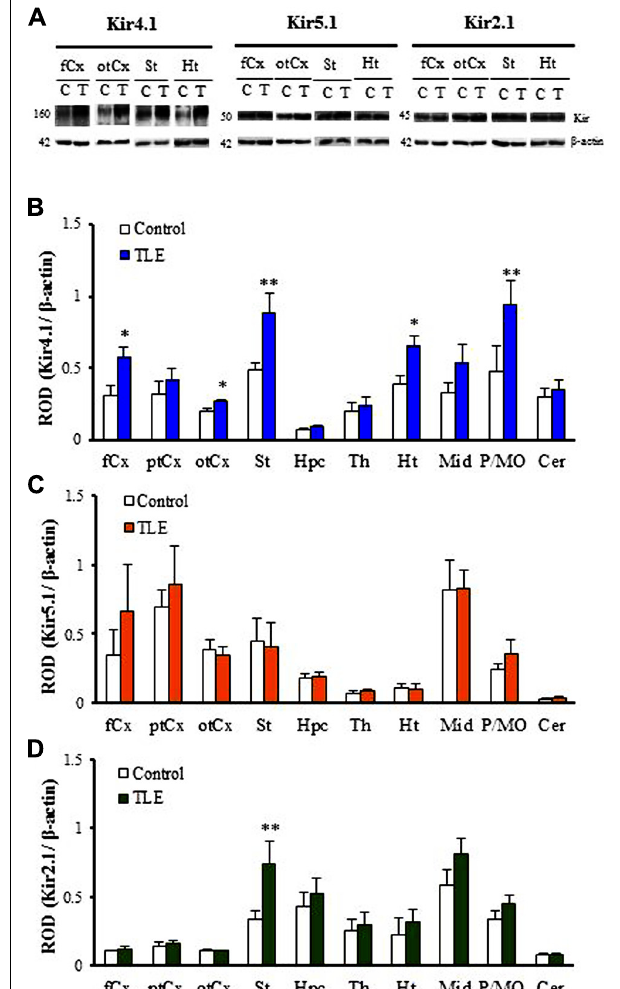
FIGURE 1 |Western blot analysis for Kir4.1, Kir5.1 and Kir2.1 expression in pilocarpine-inducedTLE rats. (A) RepresentativeWestern blots visualizing Kir4.1, Kir5.1, and Kir2.1 expression in the frontal cortex (fCx), occipito-temporal cortex (otCx), striatum (St), and hypothalamus (Ht). (B–D) Regional expression of Kir4.1 (B) , Kir5.1 (C) , and Kir2.1 (D) in pilocarpine-inducedTLE rats. Kir expression was expressed as relative optical density (ROD) to β -actin. fCx, frontal cortex; ptCx, parieto-temporal cortex; otCx, occipito-temporal cortex; St, striatum; Hpc, hippocampus;Th, thalamus; Ht, hypothalamus; Mid, midbrain; P/MO, pons/medulla oblongata; Cer, cerebellum. Each column represents the mean ± SEM of four animals. * P < 0.05, ** P < 0.01, significantly different from the control